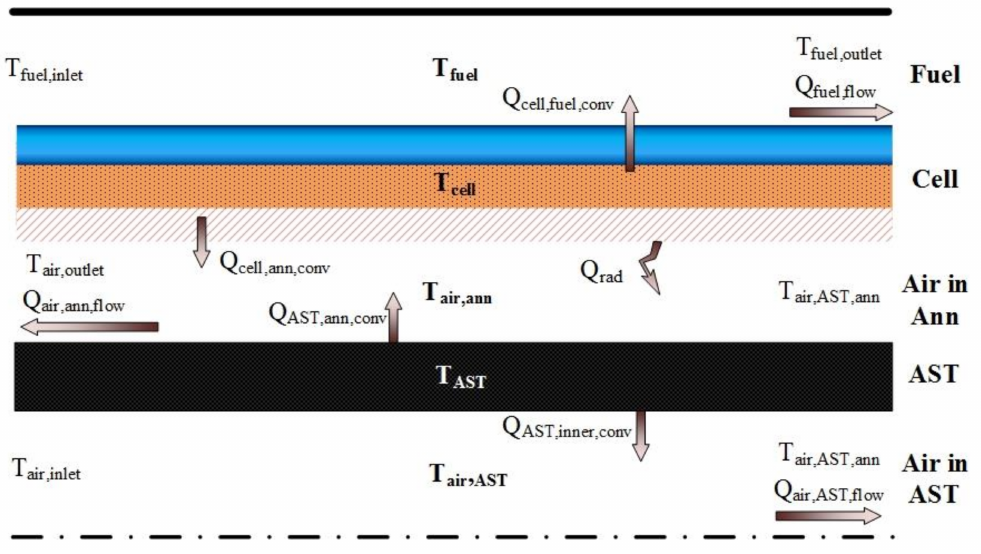
Figure 3. Heat Transfer in a Tubular solid oxide fuel